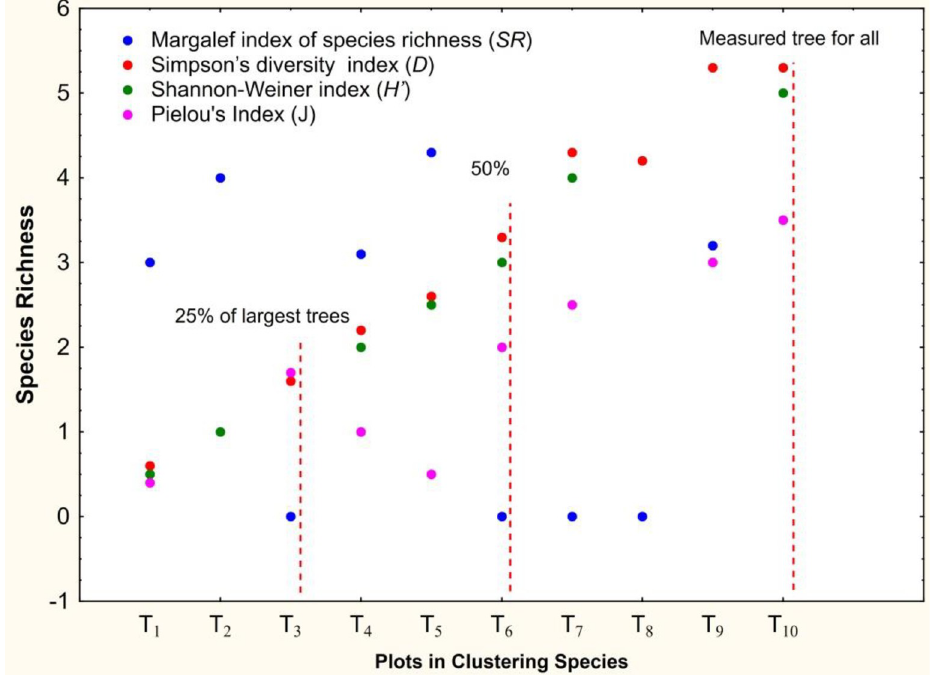
Fig 7. Species richness for clustering with k